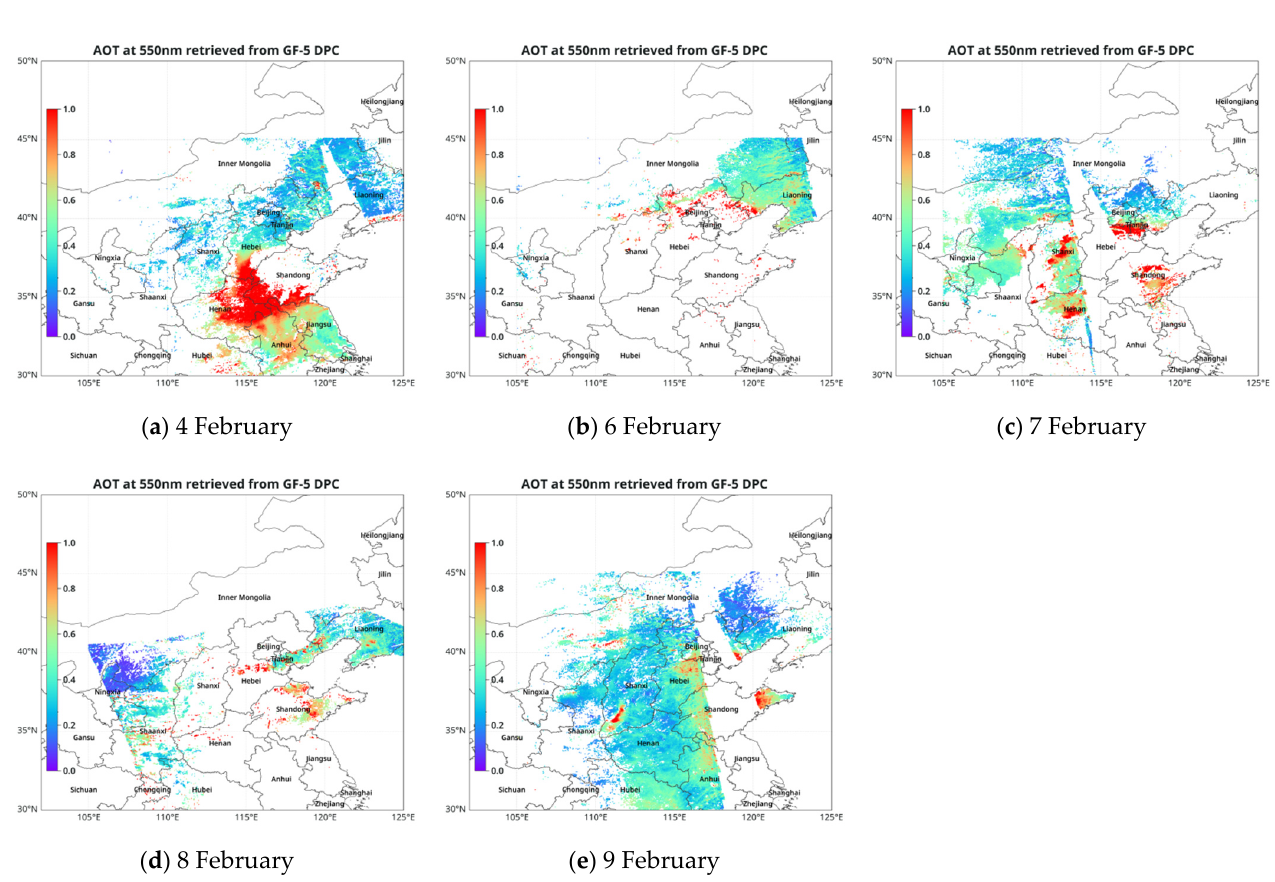
Figure 12. The MODIS fire distribution over northeast China on 6 February 2020.